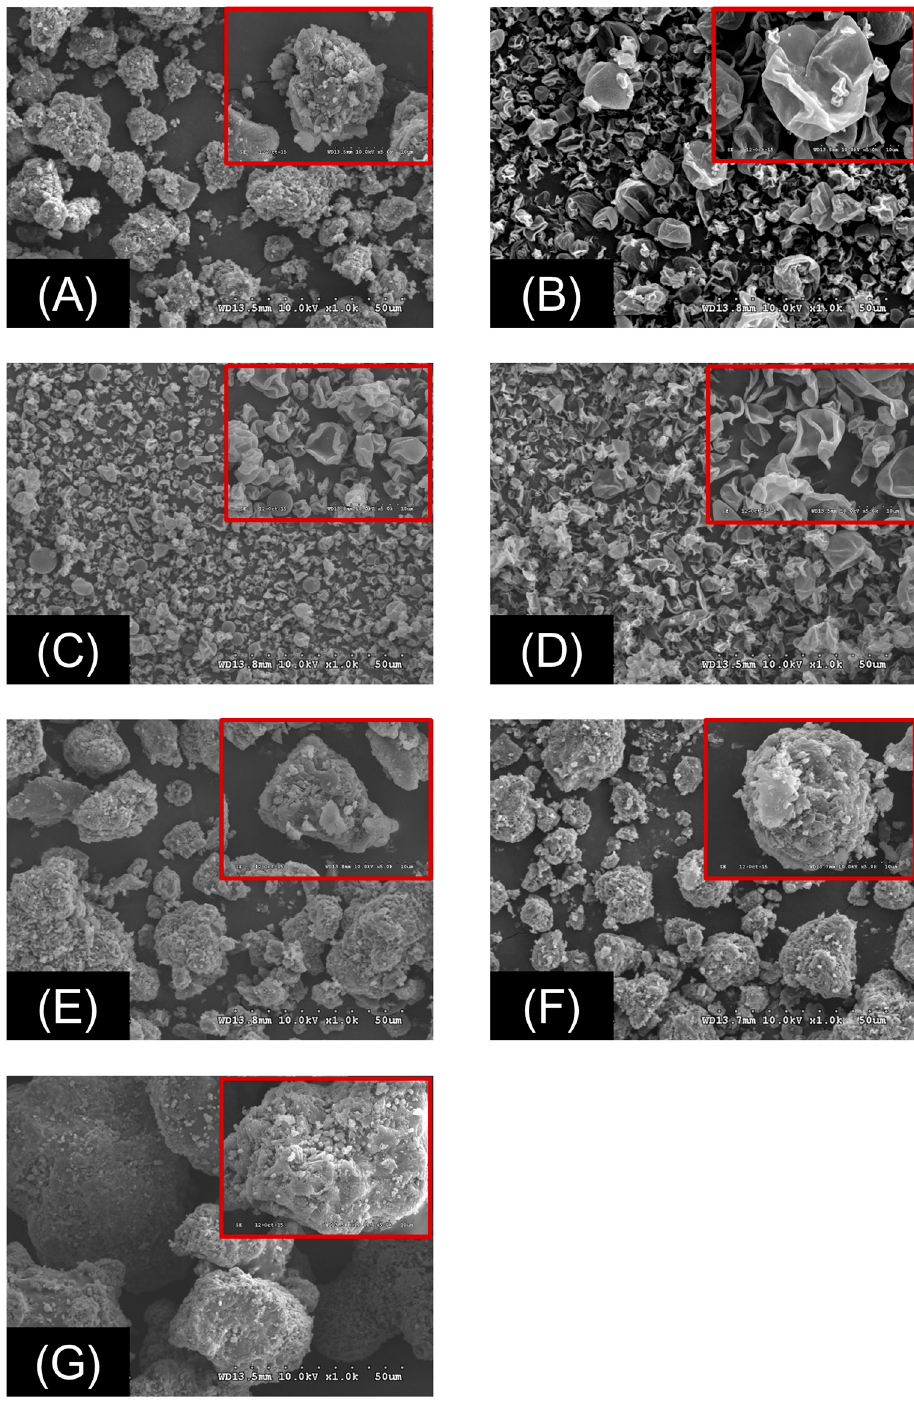
Figure 6. The SEM images of cefdinir ( A ), CSD1 ( B ), CSD2 ( C ), CSD3 ( D ), physical mixture of cefdinir and HPMC ( E ), physical mixture of cefdinir and CMC-Na ( F ), and physical mixture of cefdinir and PVP K30 ( G ). Inset indicates the magnified